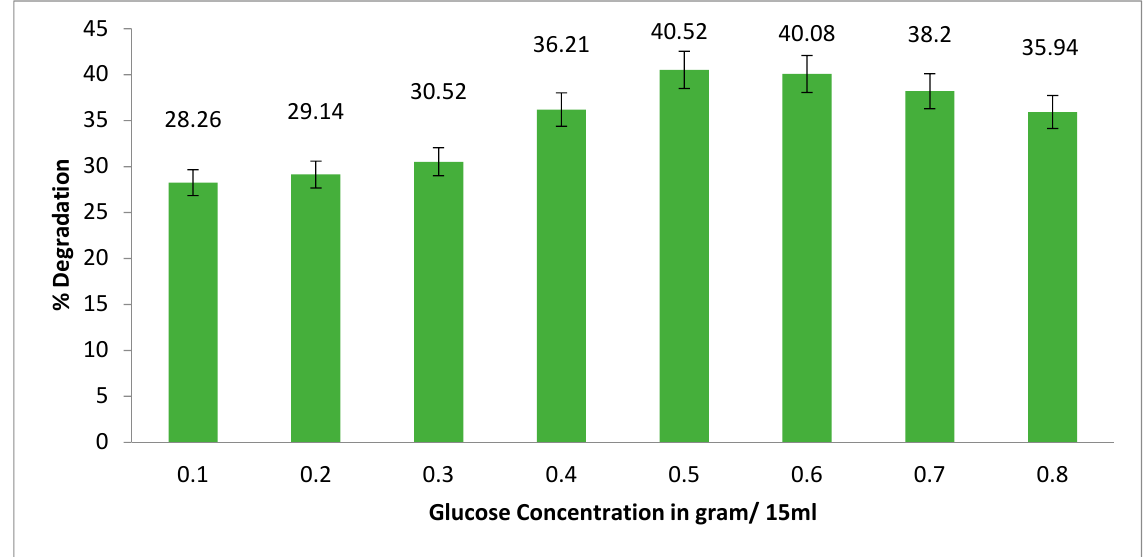
Figure 6. Glucose concentration effect on % degradation of brown 706.